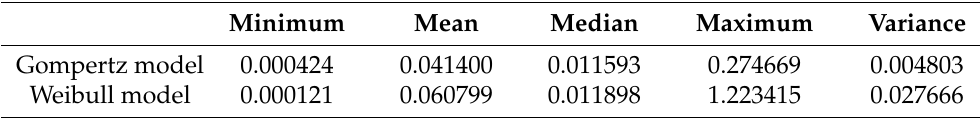
Figure 7. Study of deceased: Sample and estimated mean functions ( left ) and 95% confidence band for the mean func- tion together with the sample paths ( right ) for ( a ) the multi-sigmoidal Gompertz model and ( b ) the multi-sigmoidal Weibull model. Table 8. Study of deceased: Measures of interest from the values of resistor-average distances for each